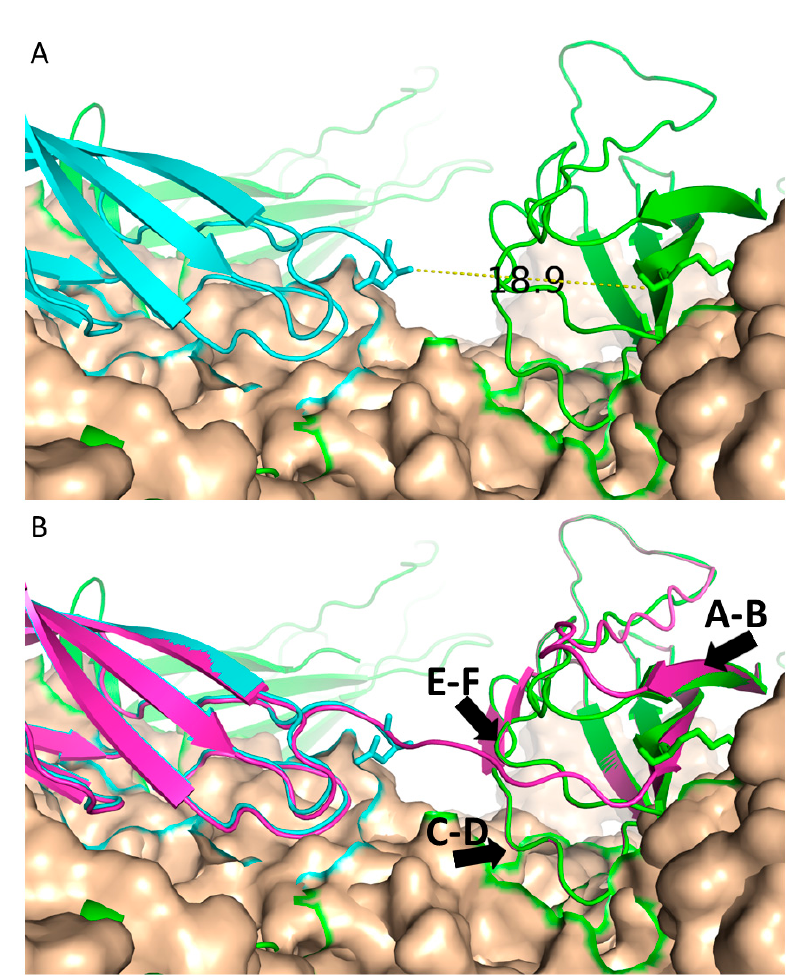
Figure 6. AAV5 (wheat) with PKD1 in green and PKD2 from PDB 6NZ0 overlaid in cyan. ( A ) The gap between K399 and N405 measures 19 Å. ( B ) PKD1 and PKD2 are connected in magenta with relevant loops labeled. The model in panel B has been energy minimized using MODELLER [25].